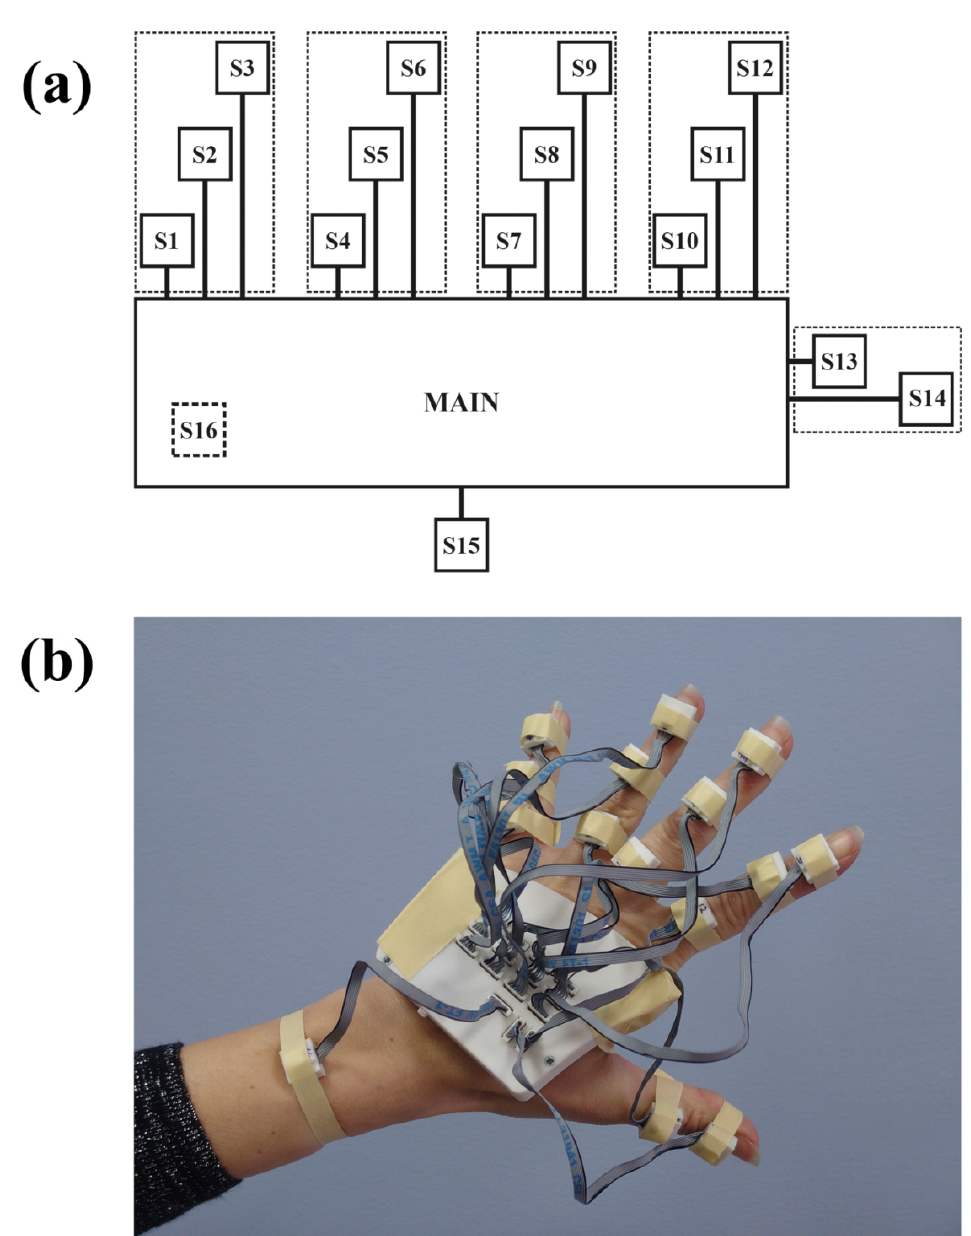
Figure 5. Arrangement of sensors in WSS: ( a ) block diagram and ( b ) view of the system placed on the hand.